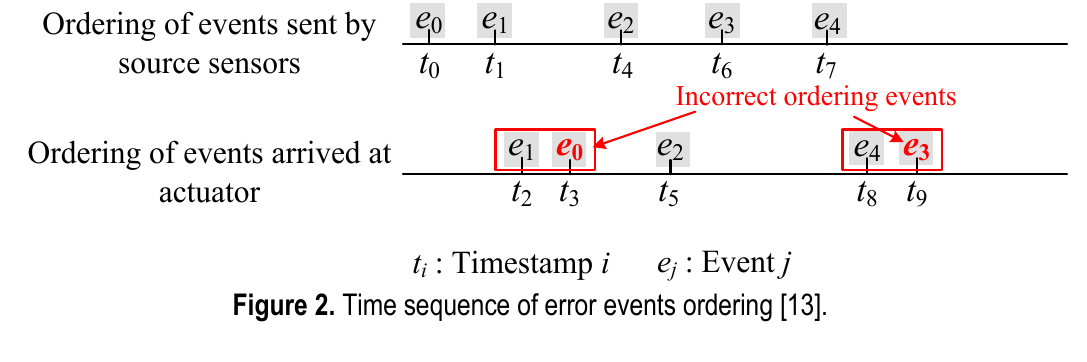
Figure 2. Time sequence of error events ordering [13].